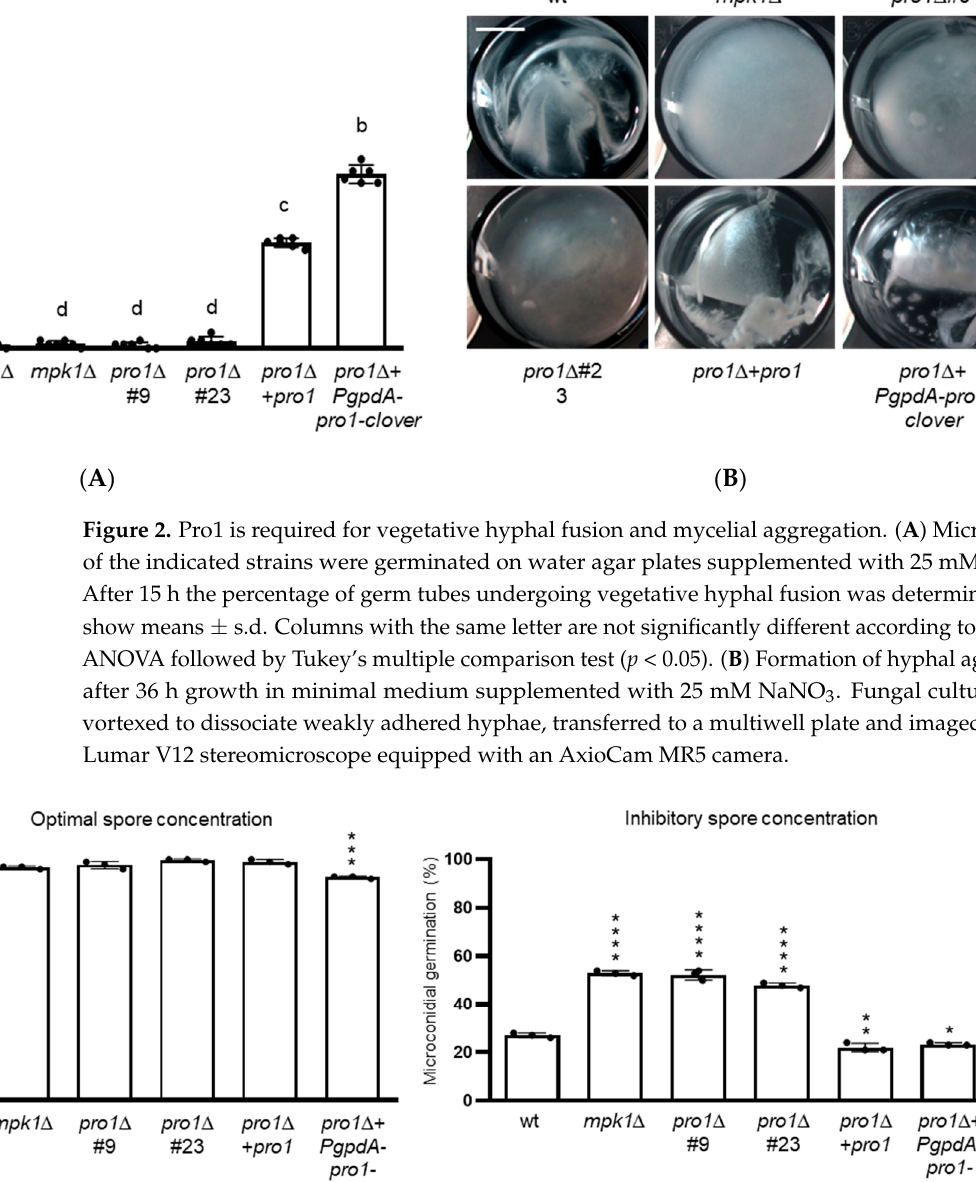
Figure 3. Pro1 controls quorum sensing of F. oxysporum microconidia. The percentage of germinated microconidia of the indicated strains at optimal (3.2 × 10 5 mL − 1 ) ( A ) or inhibitory microconidial concentrations (8.6 × 10 7 mL − 1 ) ( B ) was determined after 13 or 15 h, respectively, of incubation in minimal medium supplemented with 0.1% ( w/v ) sucrose and adjusted to pH 5.0. Data show means ± s.d. *, p < 0.05; **, p < 0.01; ***, p < 0.001; ****, p < 0.0001 versus wt according to one-way ANOVA followed by Tukey’s multiple comparison